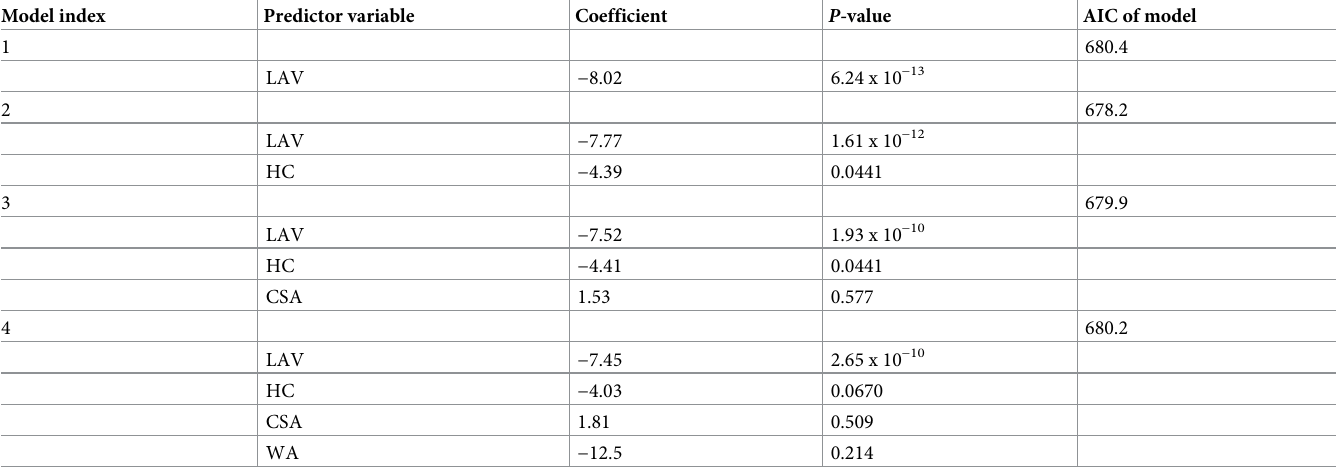
Table 4. Results of the linear model between FEV 1 /FVC and the COPD quantification. Model